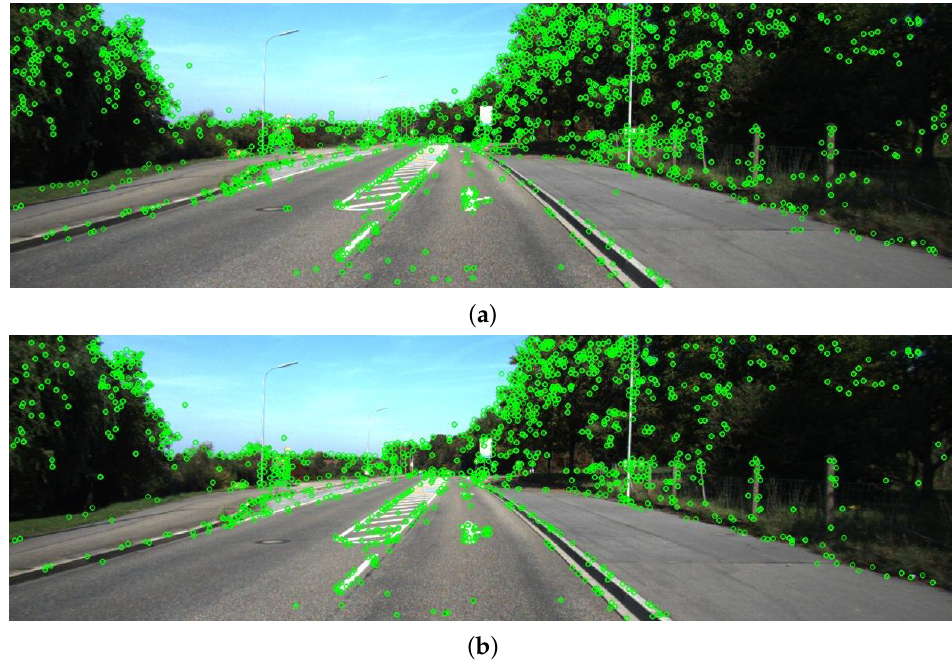
Figure 5. Extraction results of feature points of the 17th group of images to be registered. ( a ) Feature point extraction result of the SIFT algorithm; ( b ) feature point extraction result of this algorithm.